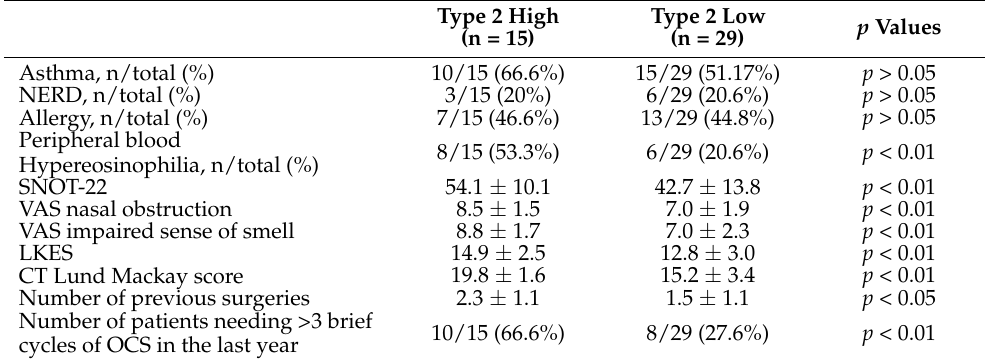
Table 3. Comparison of the most relevant clinical characteristics between the two subgroups of patients (type 2-low and -high). The right column shows the p -value of t -test comparison between the two groups. Absolute values are intended as mean ±